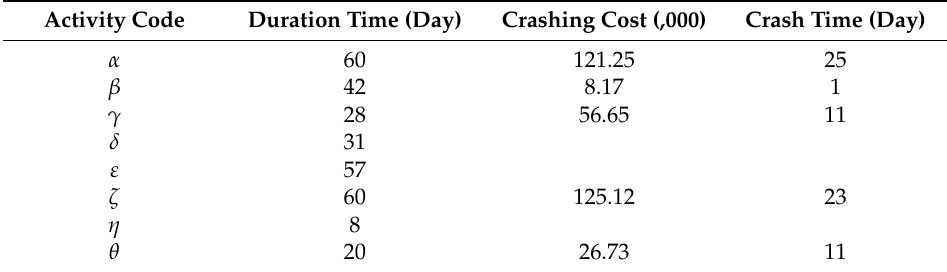
Table 5. Results of the fuzzy multiple objective linear programming